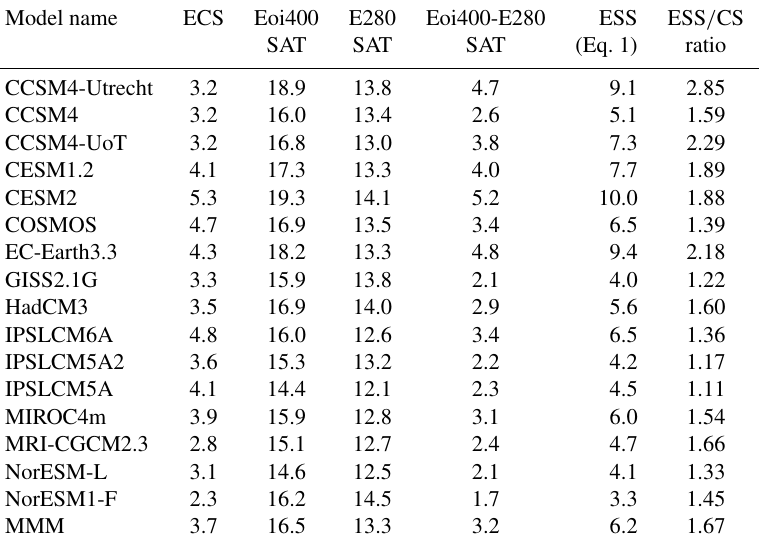
Table 2. Details of the relationship between the equilibrium climate sensitivity (ECS) and the Earth system sensitivity (ESS) for each model. MMM denotes the multi-model mean.